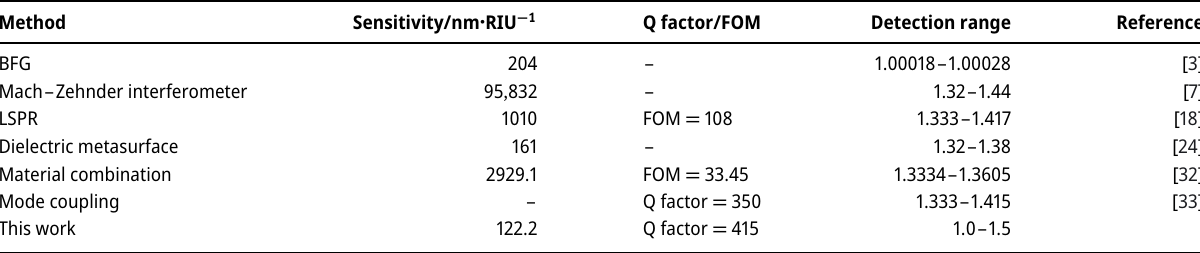
Table 1: Detecting characterizations of different refractive index sensing methods.